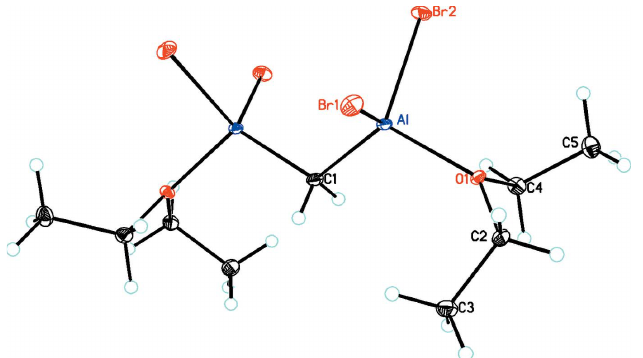
Figure 1 Molecular diagram showing the atom labeling (symmetry operation to generate the complete molecule, (cid:5) x , y , 1 parameters are at the 30%